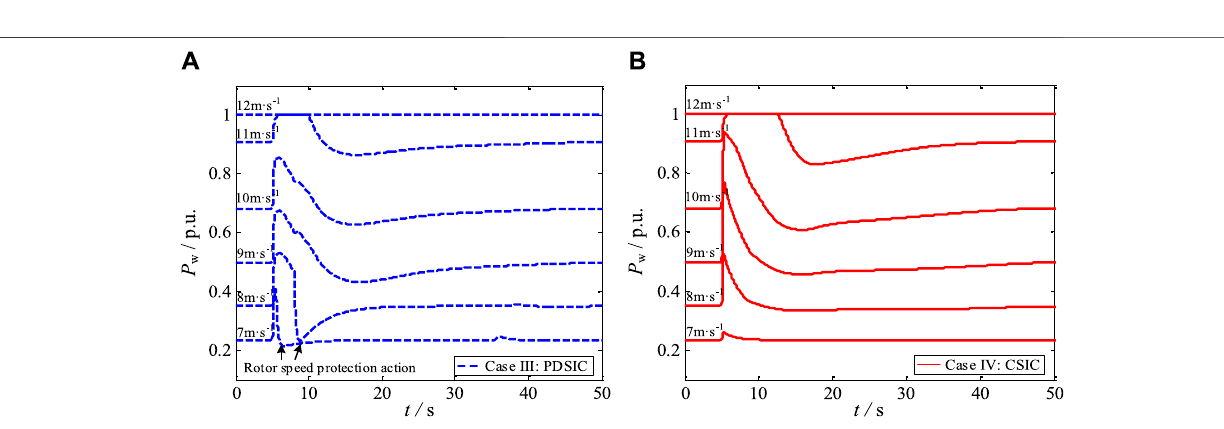
FIGURE 11 | Output power of D-PMSGs operating at different wind speeds in (A) Case III and (B) Case IV (wind farm #1).